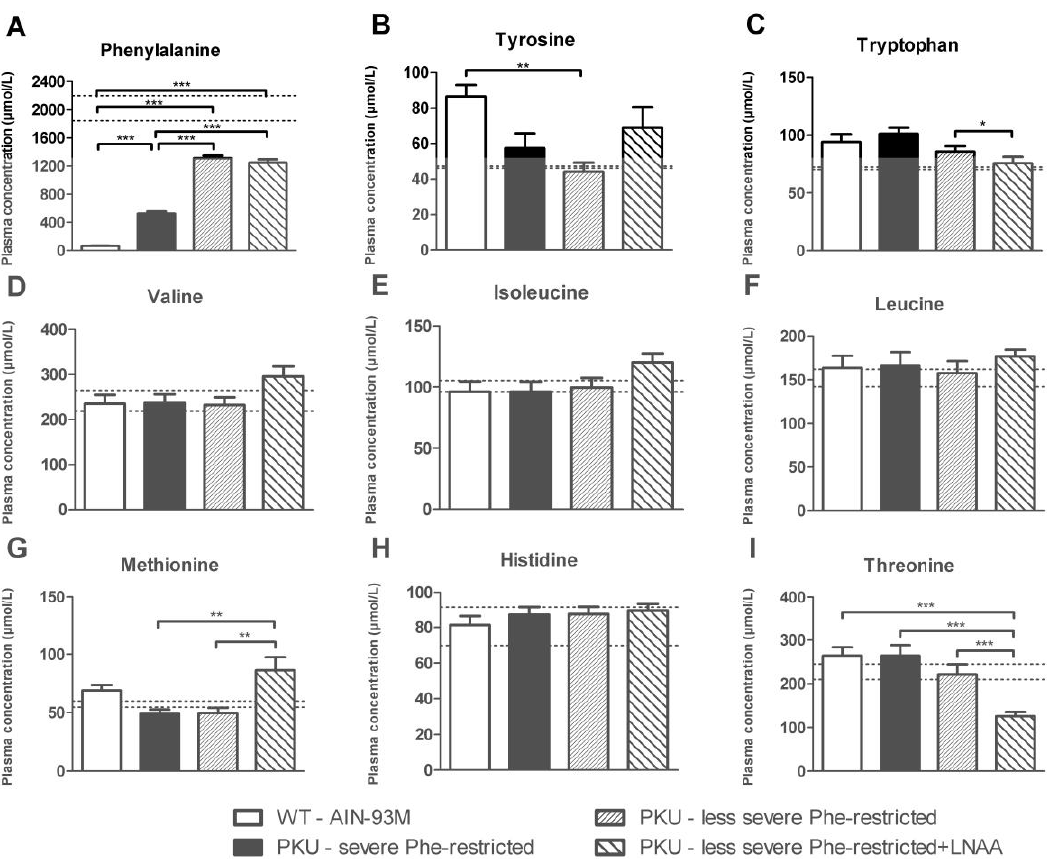
Figure 5. Plasma concentrations of ( A ) phenylalanine, ( B ) tyrosine, ( C ) tryptophan, ( D ) valine, ( E ) isoleucine, ( F ) leucine, ( G ) methionine, ( H ) histidine, and ( I ) threonine in WT and PKU mice after six weeks of receiving various diets. Numbers of mice are n = 10 for all experimental groups. Untransformed data are expressed as mean ± SEM. * p < 0.05; ** p < 0.01; *** p < 0.001 (two-sided). For comparison, dashed lines represent mean plasma amino acid concentrations obtained in C57Bl / 6 PKU mice on the AIN-93M diet in previous experiments [21,23]. Previously obtained mean plasma amino acid concentrations in PKU mice on the AIN-93M diet were expressed as proportion of data in respective WT mice and then multiplied by mean plasma amino acid concentrations of WT mice in the present study.